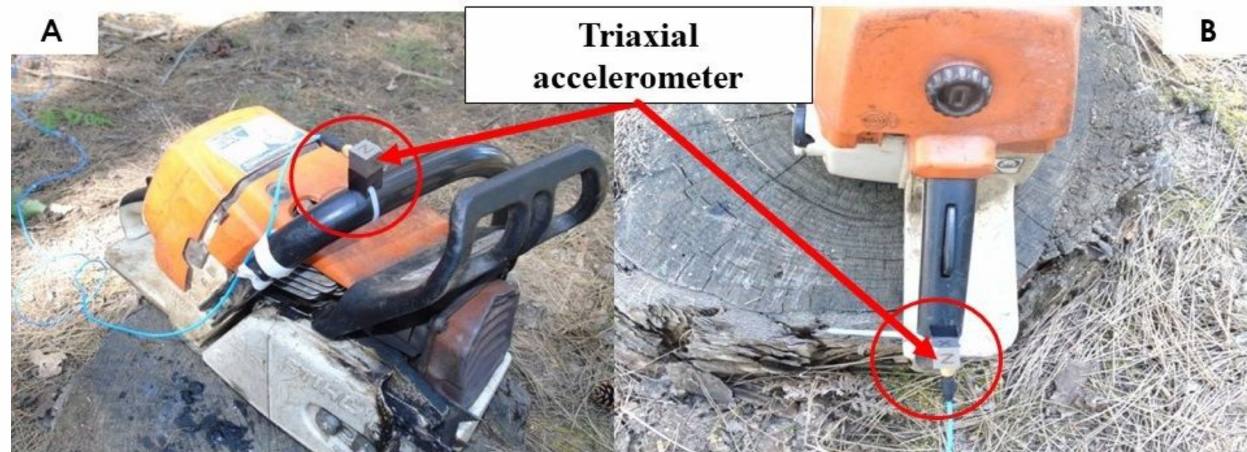
Figure 2. The triaxial accelerometers position on the chainsaw on the front ( A ) and rear ( B )